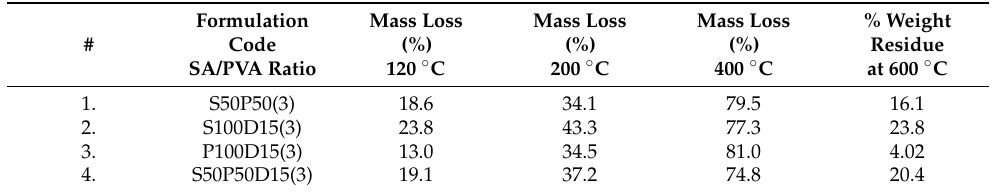
Table 2. Percentage of mass loss in drug loaded (and unloaded) SA/PVA-MMT clay reinforced nanocomposite films at different